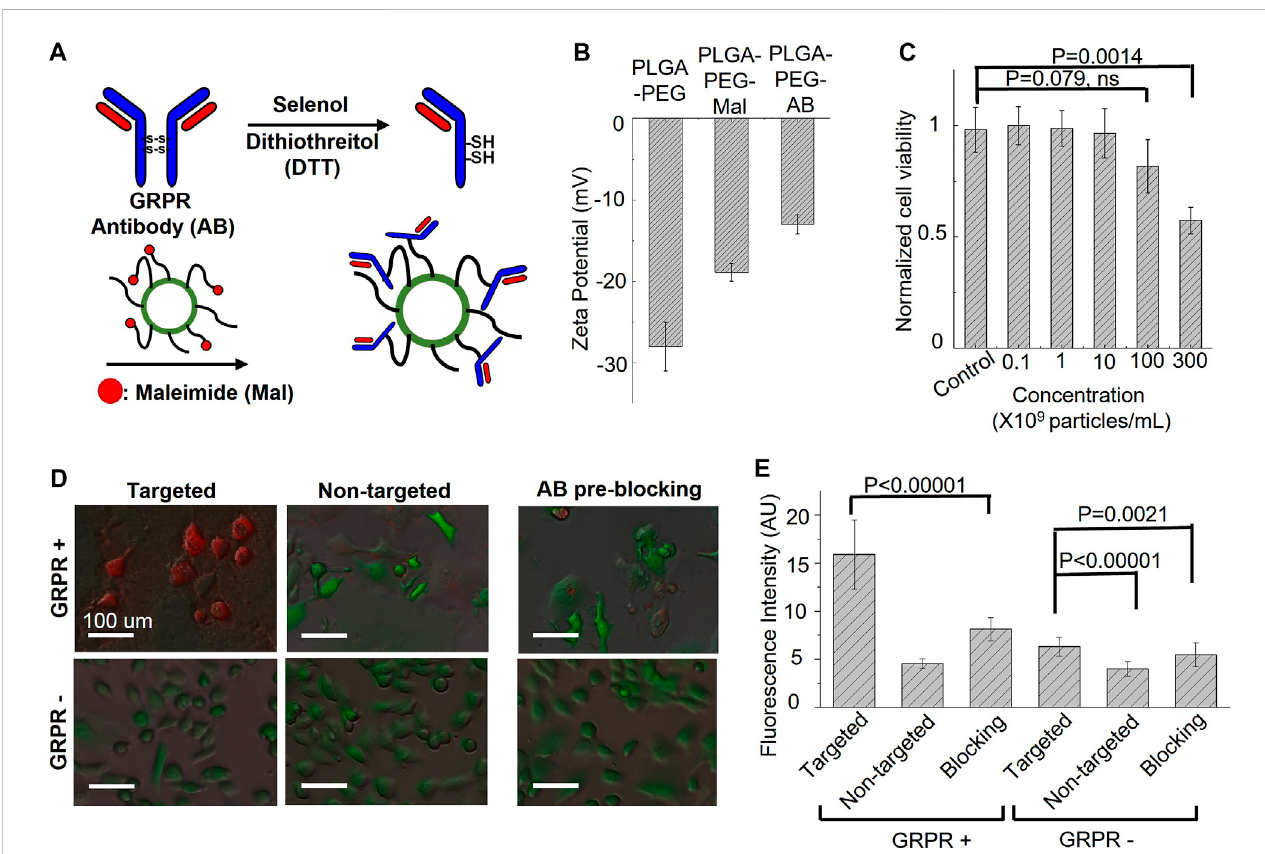
FIGURE 4 Targeting speci fi city and cytotoxicity of GRPR-targeted ICG nanobubbles. (A) The synthesis steps for anti-GRPR antibodies conjugation with an ICG nanobubble. (B) Zeta-potential of ICG nanobubbles (PLGA-PEG) with different fi ctionization (with and without maleimide groups and conjugated with anti- GRPRantibody).Barchartshowingsamplemeans(n=3)withstandard-deviationerrorbars. (C) CellviabilityofGRPR+prostatecancercellsasthefunctionof theconcentrationofICGnanobubbleincubatedwiththecells.Barchartshowingsamplemeans(n=5)withstandard-deviationerrorbars. (D) Thefusion of bright- fi eld and fl uorescent images of ICG nanobubbles incubated with PC3 (GRPR+) and DU145 (GRPR-) cells. All cells were genetically encoded with green fl uorescent protein (Green color). Red color represents ICG fl uorescence signal. (E) Fluorescent intensities of ICG from PC3 (GRPR+) cells or DU145 (GRPR – ) cells incubated either with targeted or non-targeted IGC nanobubbles. Higher intensities re fl ect higher targeting ef fi ciency. Bar chart showing sample means (n = 5) with standard-deviation error